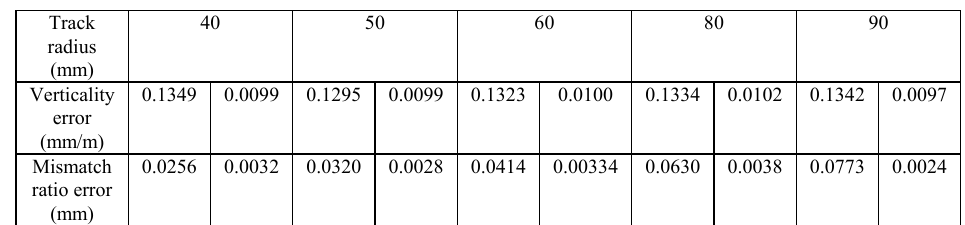
Table 2. X-Y table error comparison.